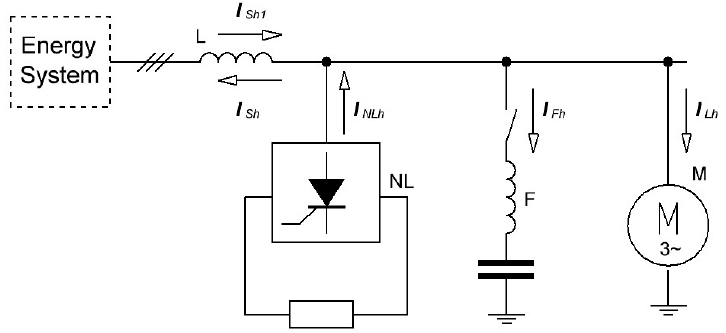
Figure 2. Scheme for the method of determination of nonlinear load parameters.